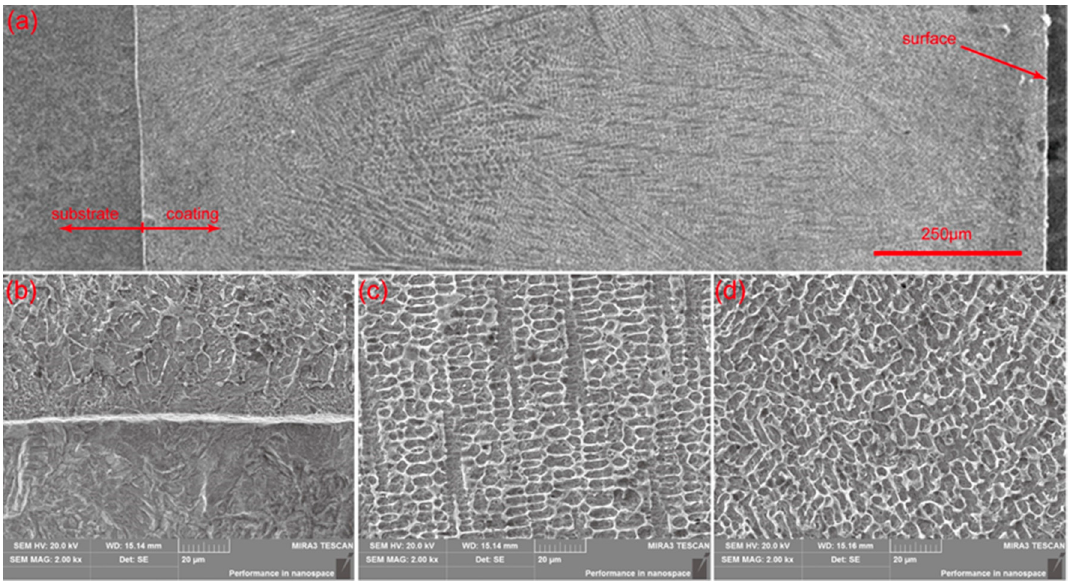
Figure 4. Scanning electron microscopy (SEM) micrographs of laser cladding specimen: ( a ) cross-sectional view; ( b ) bottom region; ( c ) middle region; ( d ) upper region.